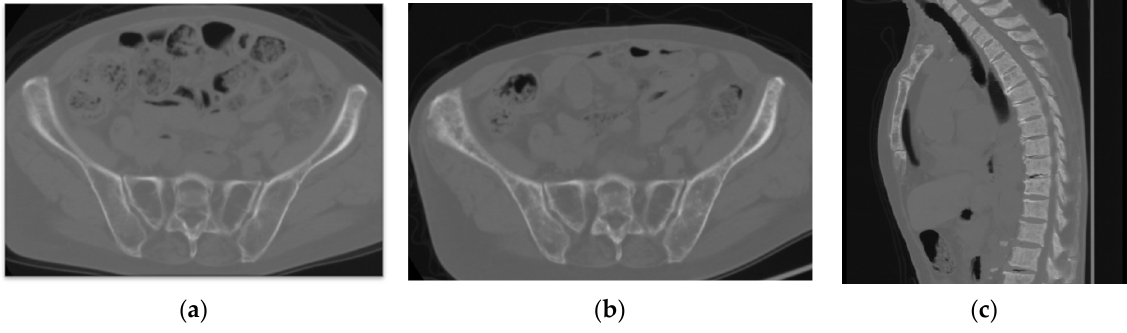
Figure 2. Computed tomography (CT) images. ( a ) CT image obtained 1 year prior to the consultation for chronic back pain, with no abnormal findings in the pelvis. ( b ) CT image of the same field of view obtained at the time of consultation for back pain revealed sclerotic changes in the sacral ala and iliac wing. ( c ) Sclerotic changes were also detected throughout the thoracic spine and sternum. The rapid increase in bone mineral density combined with the abrupt increase in serum levels of biphasic bone metabolic markers was comparable to findings in Paget’s disease. Therefore, a bone biopsy of the sacral ala and a gastric mucosal biopsy via a gastrointestinal fiberscope were performed in the same patient to identify whether these findings were a result of Paget’s disease or further gastric cancer progression. Based on the signet-type deformities in the inter-trabecular areas, bone abnormality was confirmed as metastatic disease (Figure 4a). Recurrence of cancer in the residual postoperative stomach (group 5, poorly differentiated adenocarcinoma; Figure 4b,c) was also confirmed. Based on these findings, a final diagnosis of recurrent gastric cancer with multiple bone metastases was